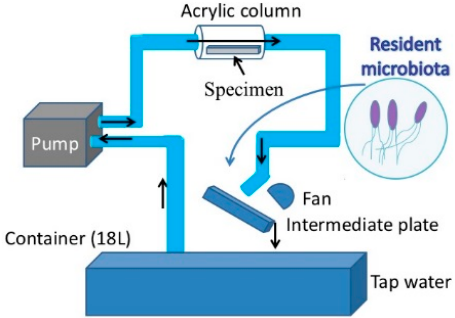
Figure 1. Previous laboratory biofilm reactor (LBR) for our studies.